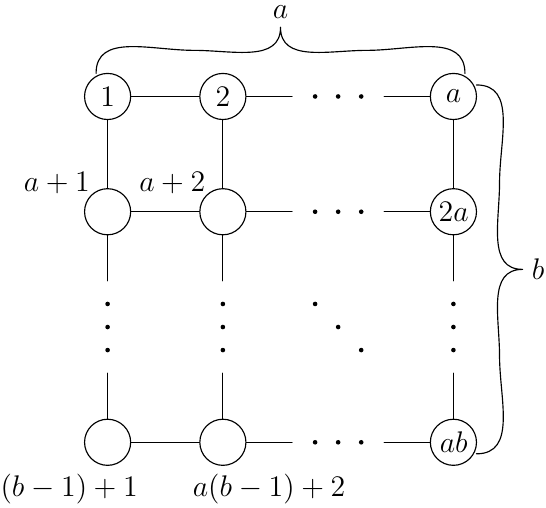
and its vertex labels. b,a